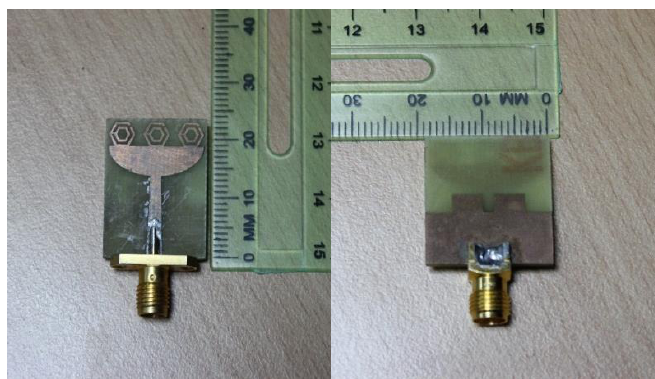
Figure 7. Fabricated prototype of the designed UWB antenna. Sensors 2018 , 18 , x